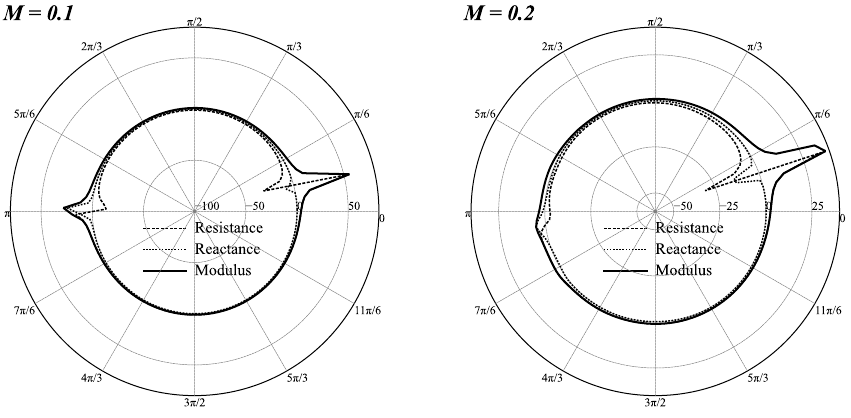
Figure 15. Directivity pattern at r = 5 R 2 of the local impedance Z = R + j X at ka = 3.4 obtained using Equations (5) for M b = 0.1 and M b =